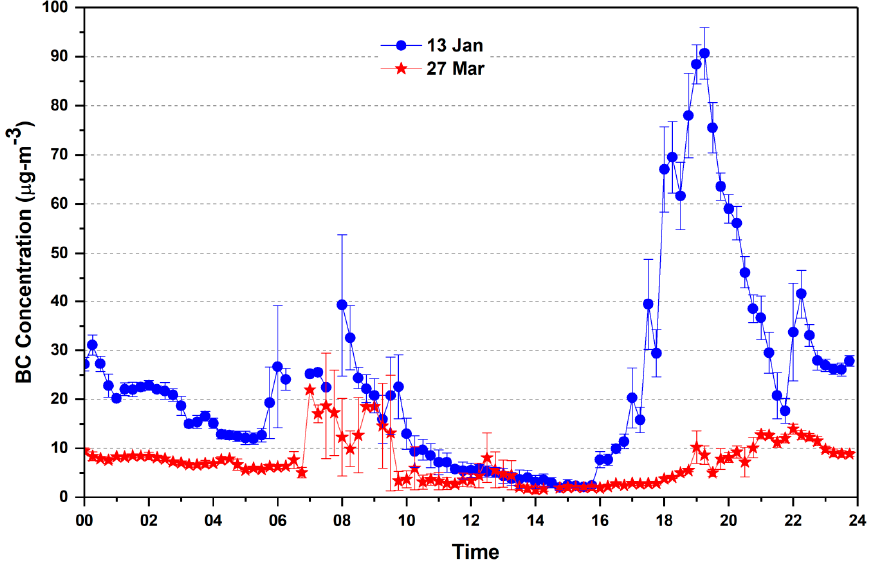
Figure 4. Diurnal variation of black carbon (BC) concentration at fixed campaign site on 13 January and 27 March 2013 (averaged for 15-min with standard deviation).